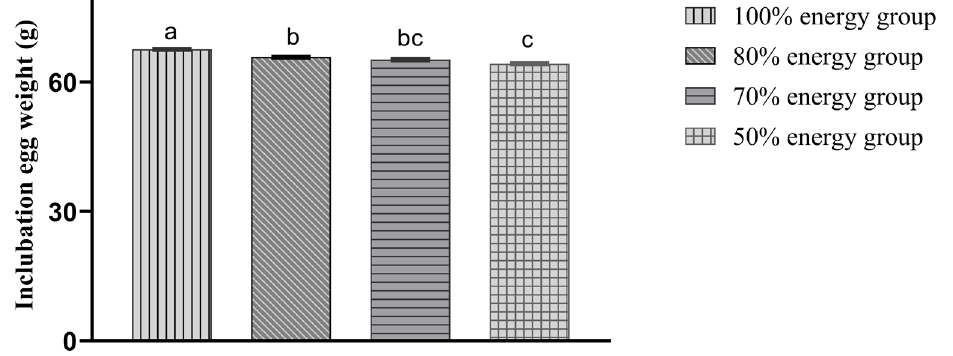
Figure 1. Comparison of incubation egg weight in different treatment groups. At a laying rate of more than 65%, 37 weeks, approximately 300 eggs per treatment were randomly collected over 6 days. Eggs were stored in a separate room at 10°C until incubation. And the incubation egg weight (g) in 100%, 80%, 70%, and 50% energy groups were 67.61±0.21 a , 65.79±0.21 b , 65.23±0.23 bc , 64.25±0.22 c , individually. The incubation egg weights in the 80%, 70%, and 50% energy groups were significantly lower (p<0.05) than those in the 100% energy group. Moreover, the hatching egg weight in the 50% energy group was significantly lower (p<0.05) than those in the 80% and 70% energy groups.